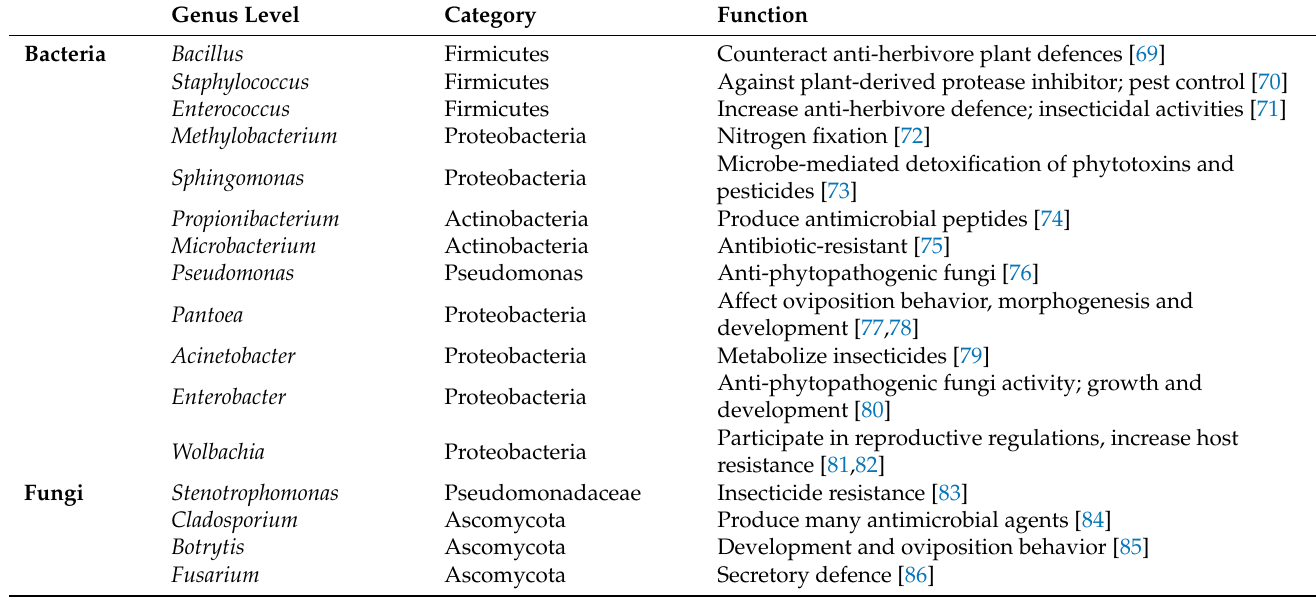
Table 1. The category, function and reference for some important symbiotic bacteria and fungi of lepidopteran